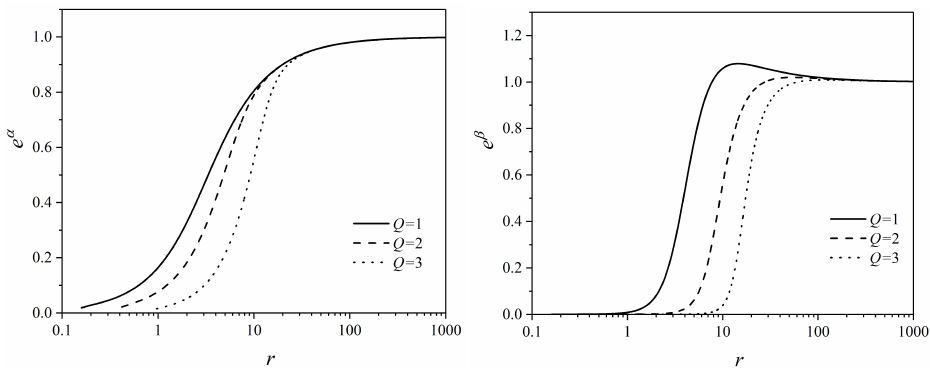
Figure 1. Behavior of metric functions e α ( left ) and e β ( right ) for M = 1 and different Q